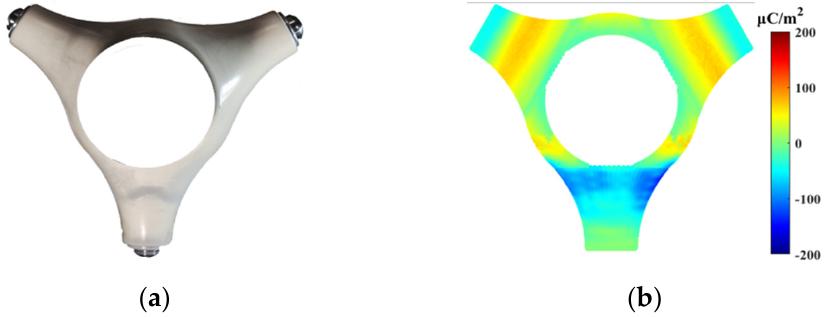
Figure 5. Effect of metal dust on surface charge of tri–post epoxy insulator under +100 kV DC voltage. ( a ) Adsorption distribution of metal dust; ( b ) Charge distribution of metal dust.